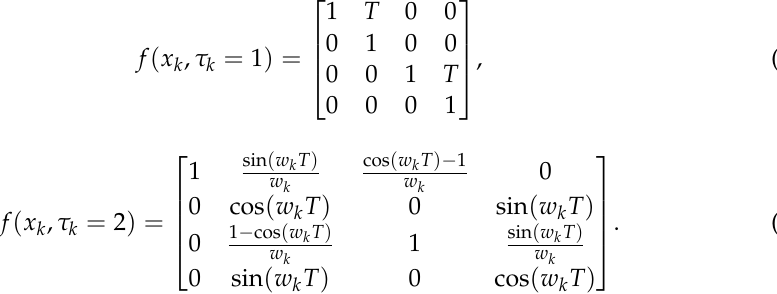
Figure 2. The diver multidirectional movement model set. In Figure 2, the red circle represents the position of the diver target at the current moment, and the direction indicated by the eight arrows is the possible predicted direc- tion of the target. Each direction includes two uniform linear motion models with speeds of 0.75 and 1.25 times the target speed range at the previous moment.